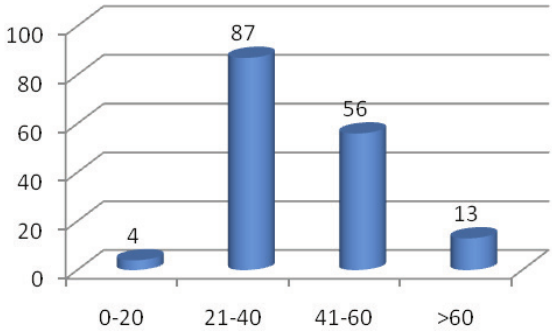
Figure 1: Age distribution of patients Surgery was indicated for symptomatic gallstone in 43% of the patients while complications of the stone were the indication in 54.5% of the patients. In three percent of patients it was for the gallbladder polyp. (Table 1) Table 1: Indication for cholecystectomy